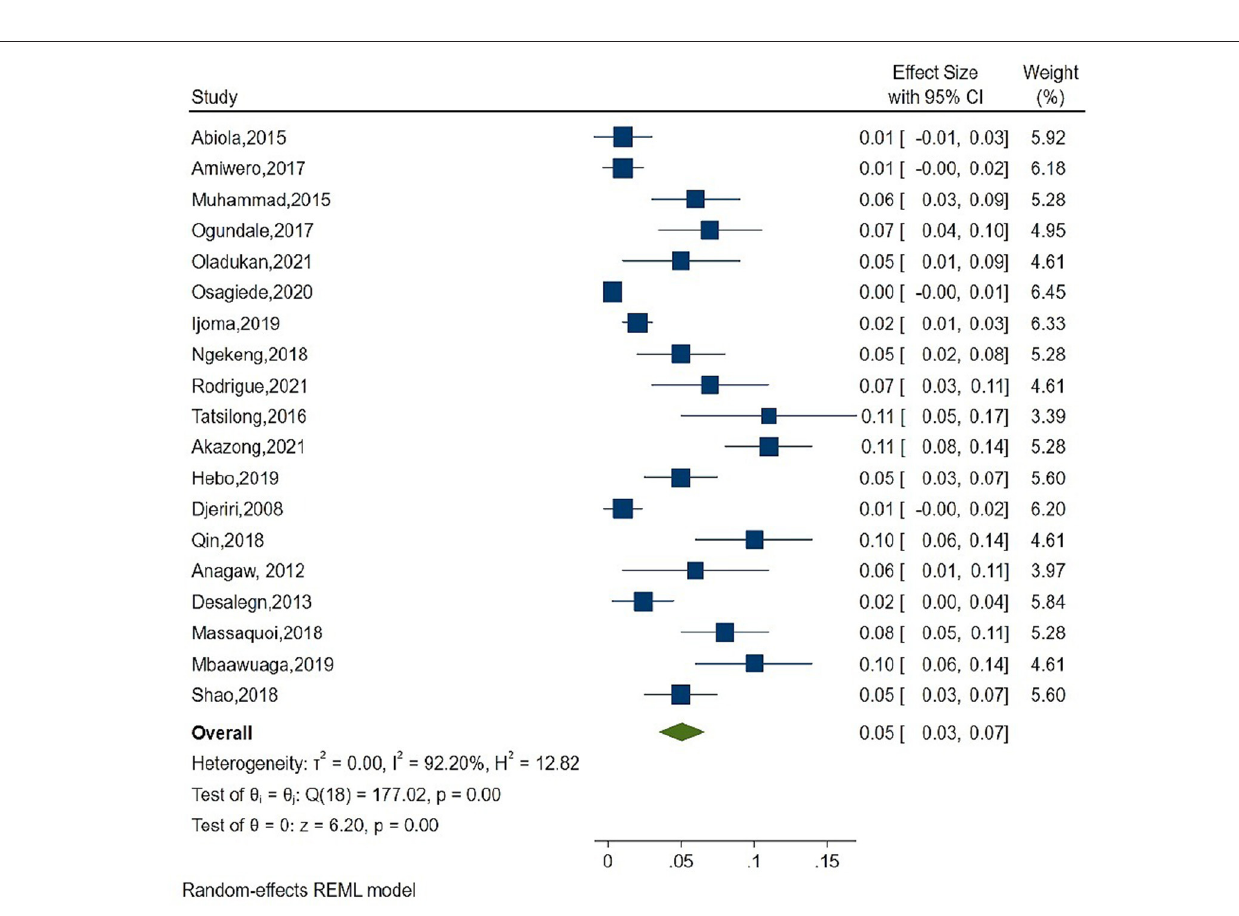
Frontiers in Public Health |